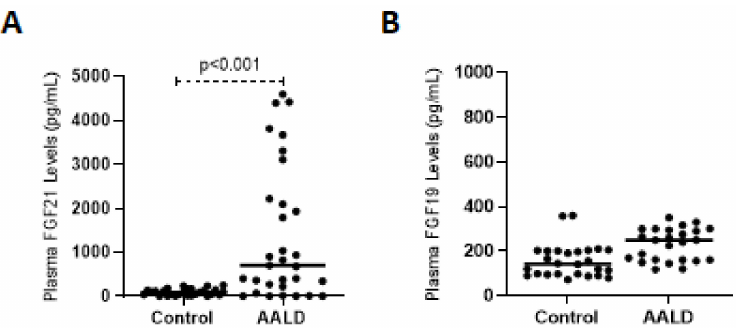
Figure 8. Box-and-whisker plots showing plasma FGF21 ( A ) and FGF19 ( B ) levels in human plasma samples quantified by ELISA (AALD, n = 31, controls, n = 27). AALD, alcohol-associated liver disease. p < 0.05 was considered